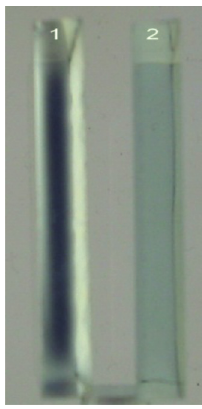
Fig. 7: Different stress states in glass: 1) float annealed 2) refined with alumina nanoparticles